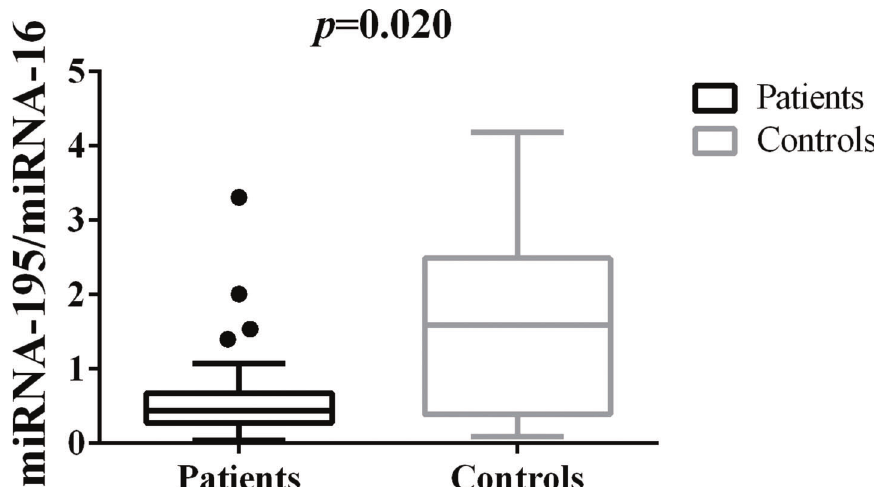
Figure 1 - Patterns of miRNA-195 Expression in Breast Cancer Tissues. miRNA-195 expression in tumor (N=55) and healthy breast tissues (N=9). miRNA-195/miRNA-16 expression ratios were calculated using the 2 - DD Ct method. The expression values are presented as the DD Cq value on a log 2 scale. Statistical analysis was performed using a generalized linear model and the data are presented as the mean ± SE values. The black dots represent the outliers. Table 2 - miRNA-195 expression stratified according to prognostic factors. Breast cancer prognostic